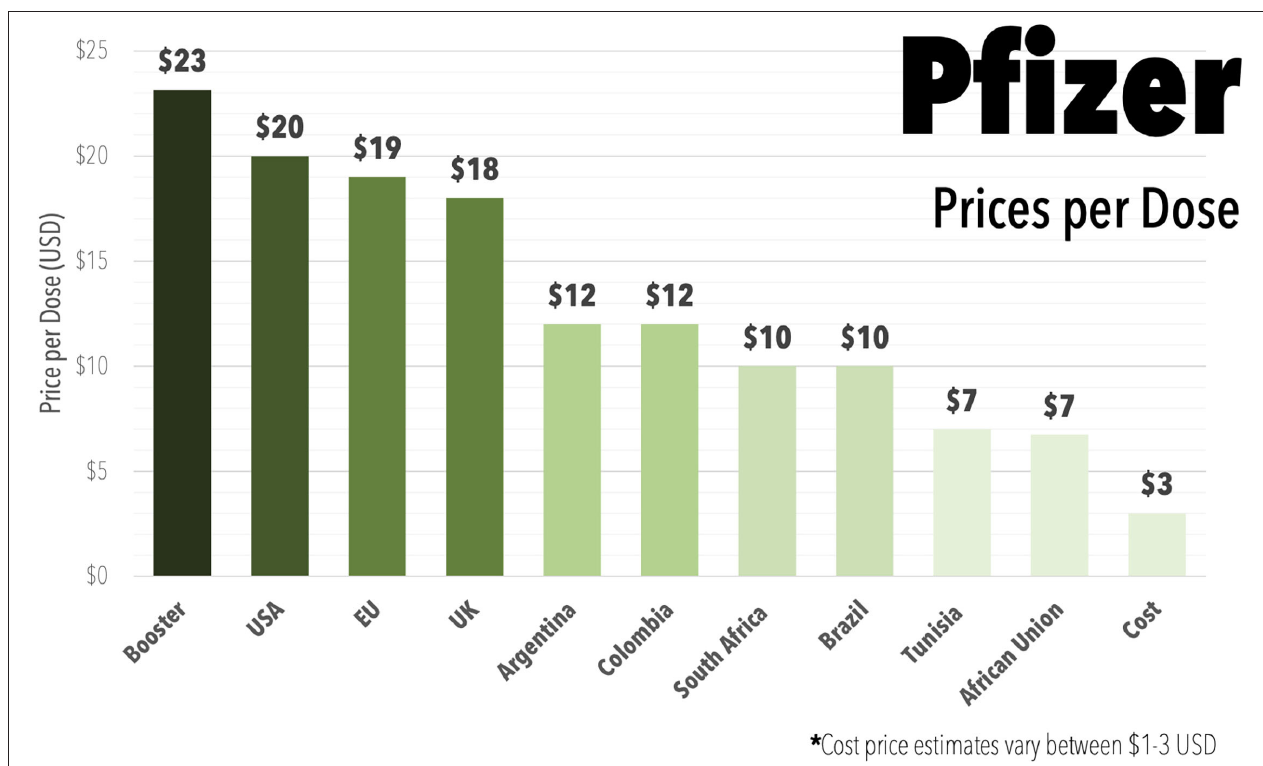
FIGURE 2 | Bar graph displaying the range of prices reported to be paid in different countries or areas of the world for the Pfizer mRNA COVID-19 vaccine (Comirnaty) during 2021, including reported higher prices being charged for booster doses and including estimate on the cost of production. Data Oxfam Coronavirus Dashboard (32). Cost price estimate from